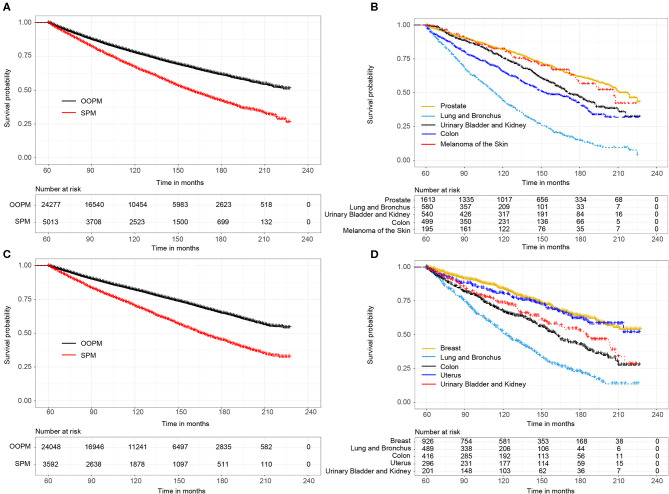
(A) Overall survival (OS) between male survivors with and without second primary malignancies (SPMs) based on the Kaplan-Meier method; (B) OS between male survivors with top 5 SPMs sites; (C) OS between female survivors with and without SPMs; (D) OS between female survivors with top 5 SPMs sites.